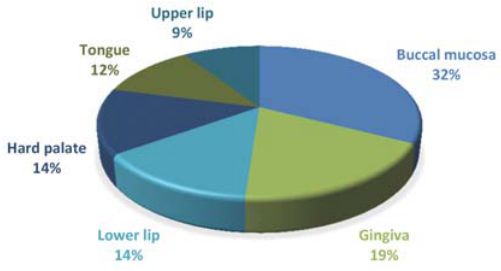
FIGURE 2. Localization of non-malignant lesions in oral cav-